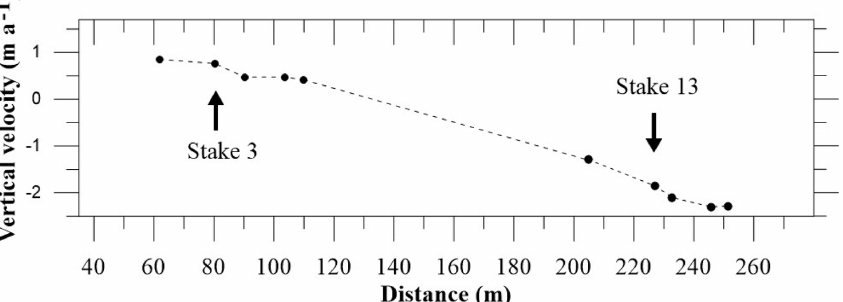
Figure A1. Vertical velocities obtained from 10 stakes measured in 2018/2019 on a longitudinal profile located between stakes 3 and 13 (see Fig. 2 for the locations of stakes 3 and